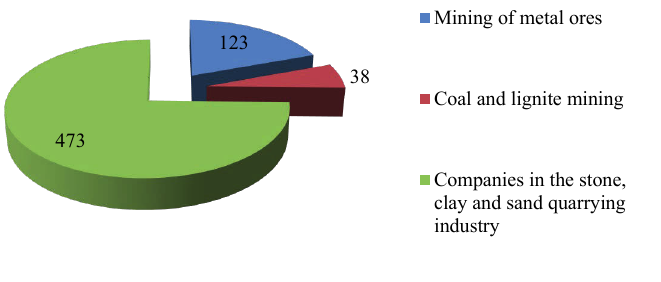
Fig. 7. Number of active subsoil users in